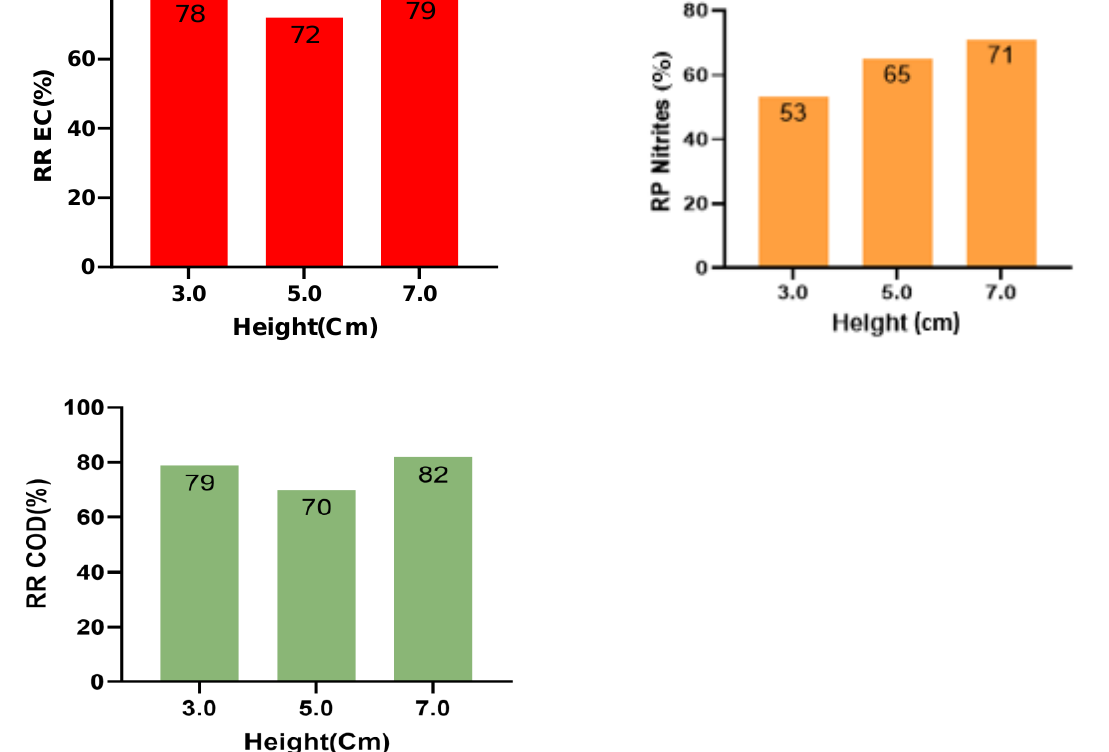
Figure 10. Parametric removal percent as a function of height (effluent pH 6.5; temperature 30 °C; height range 3 – 7 mm; particle size 7 cm; flow rate 20 mL/min − 1 ).